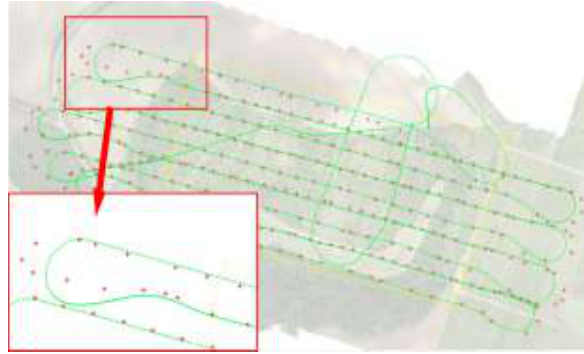
Figure 6. Comparison of GPS coordinates of camera (red cross) and autopilot (green line)